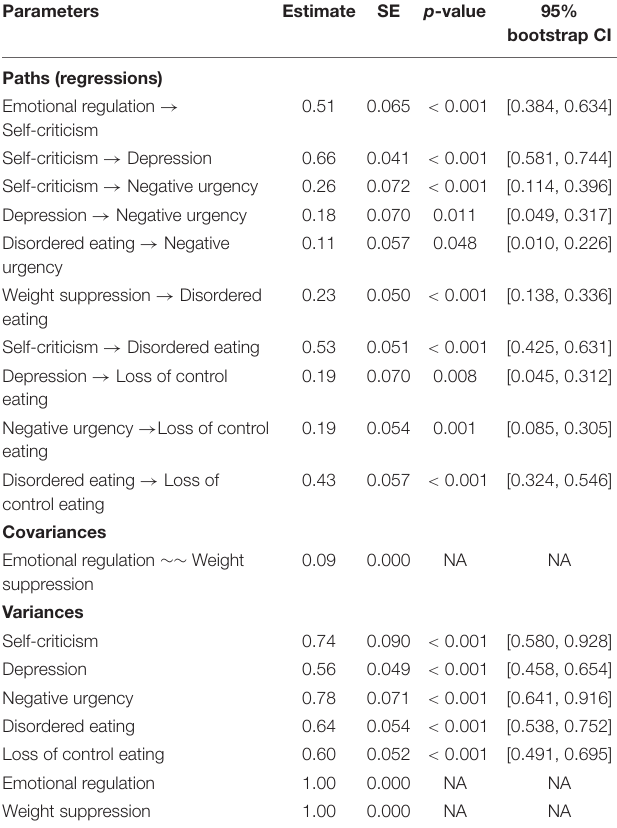
TABLE 2 | Parameter estimation of the final model outlined in Figure 2